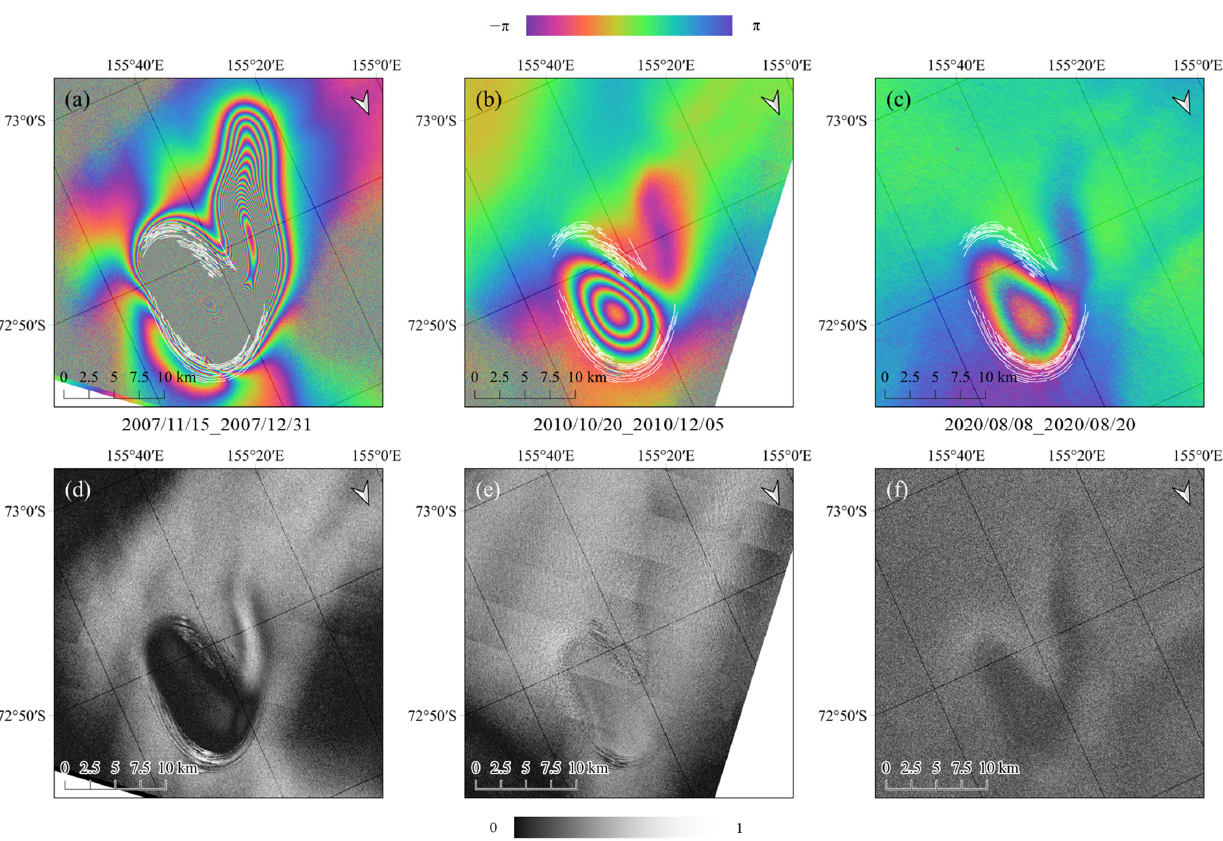
Figure 10. Result images of DInSAR and coherence. ( a , d ) are DInSAR and coherence images using the ALOS PALSAR pair acquired on 15 November and 31 December, 2007; ( b , e ) are DInSAR and coherence images using the ALOS PALSAR pair acquired on 20 October and 5 December, 2010; ( c , f ) are DInSAR and coherence images using Sentinel ‐ 1 SAR pair acquired on 8 August 8 and 20 August, 2020. The white lines are cracks drawn based on ( a , d ).